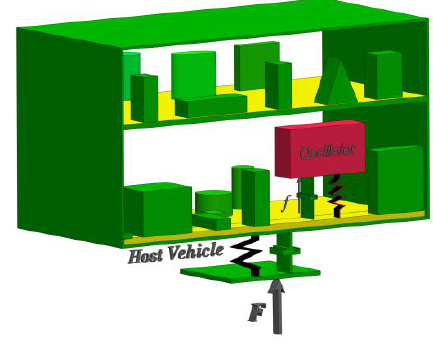
Figure 1. Highly dynamic host vehicle with installed crystal